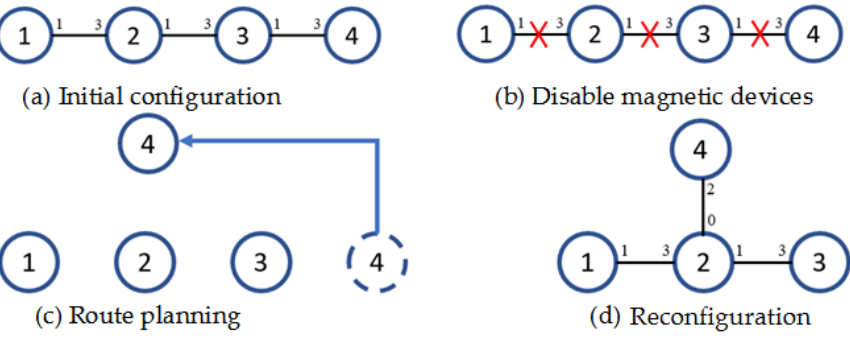
Figure 11. Modular vehicle configuration reorganization process .